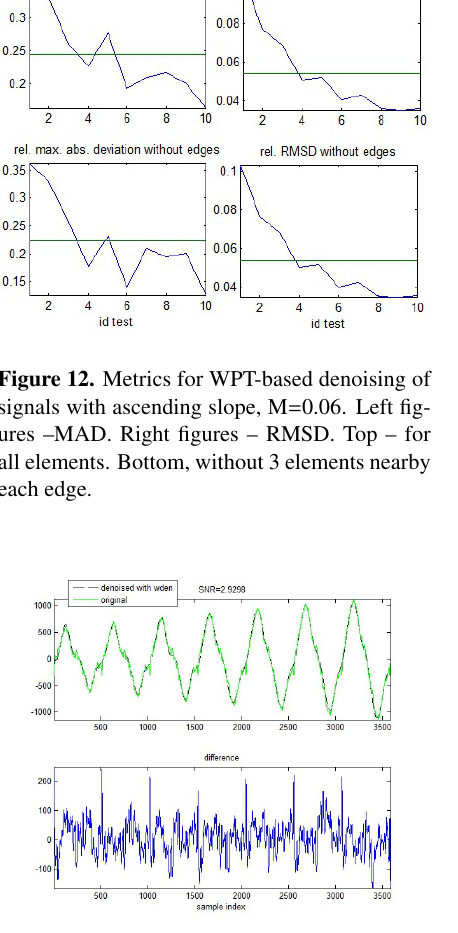
Figure 14. Ascending slope, M = 0.06, denoising with wden. Top MAD, bottom –